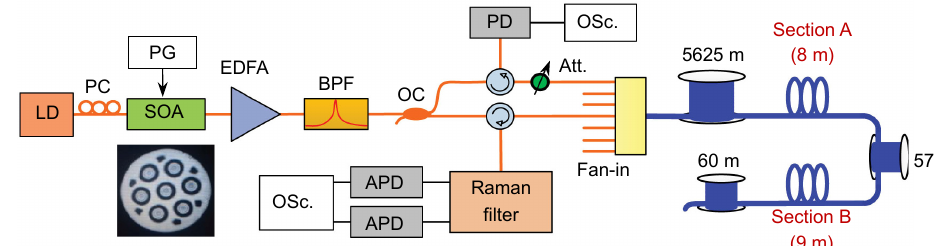
Fig. 15 | Experimental setup of the MCF SDM ROTDR and φ -OTDR hybrid sensor . LD: Laser diode; PC: polarization controller; SOA: semi- conductor optical amplifier; PG: pulse generator; EDFA: erbium-doped fiber amplifier; BPF: band-pass filter; OC: optical coupler; Att.: tunable attenuator; APD: avalanche photodiode; PD: photodetector; OSc.: oscilloscope; the inset shows the cross sectional view of the seven-core MCF. Figure reproduced from ref. 61 ,